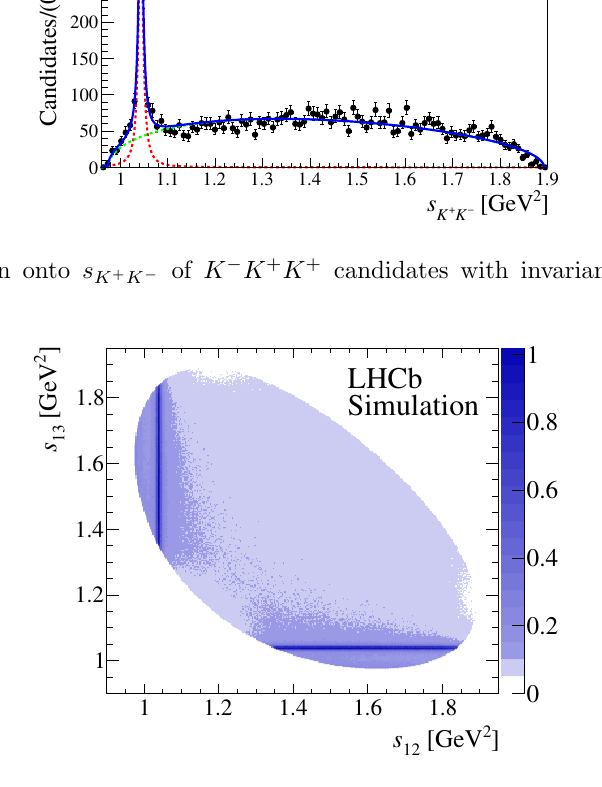
Figure 5 . High-resolution histogram representing the background model used in the Dalitz plot (cid:12)ts. ponent is nearly constant in both sidebands, indicating that the background composition is independent of m ( K (cid:0) K + K + ). A linear interpolation is used to obtain the fraction